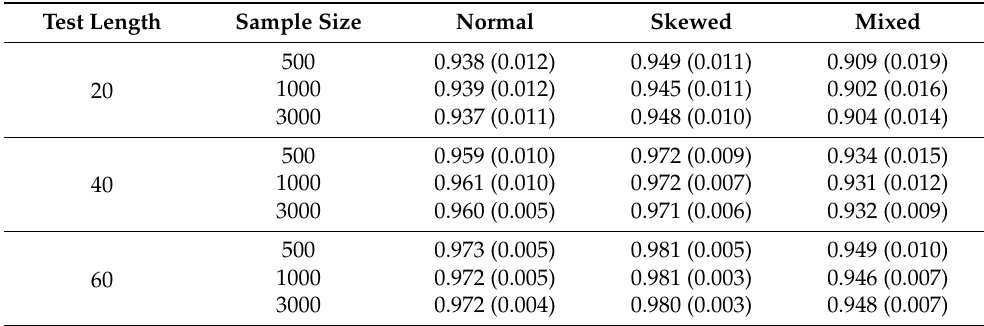
Table 3. AUC indices by test length, sample size, and ability distribution.